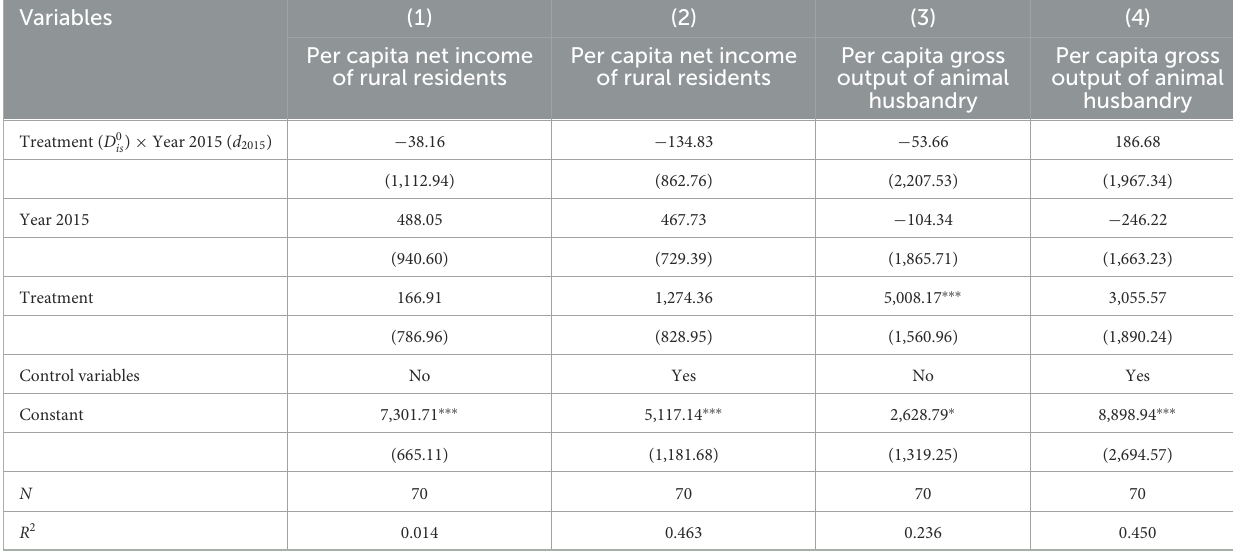
TABLE 5 Results of testing the parallel trend